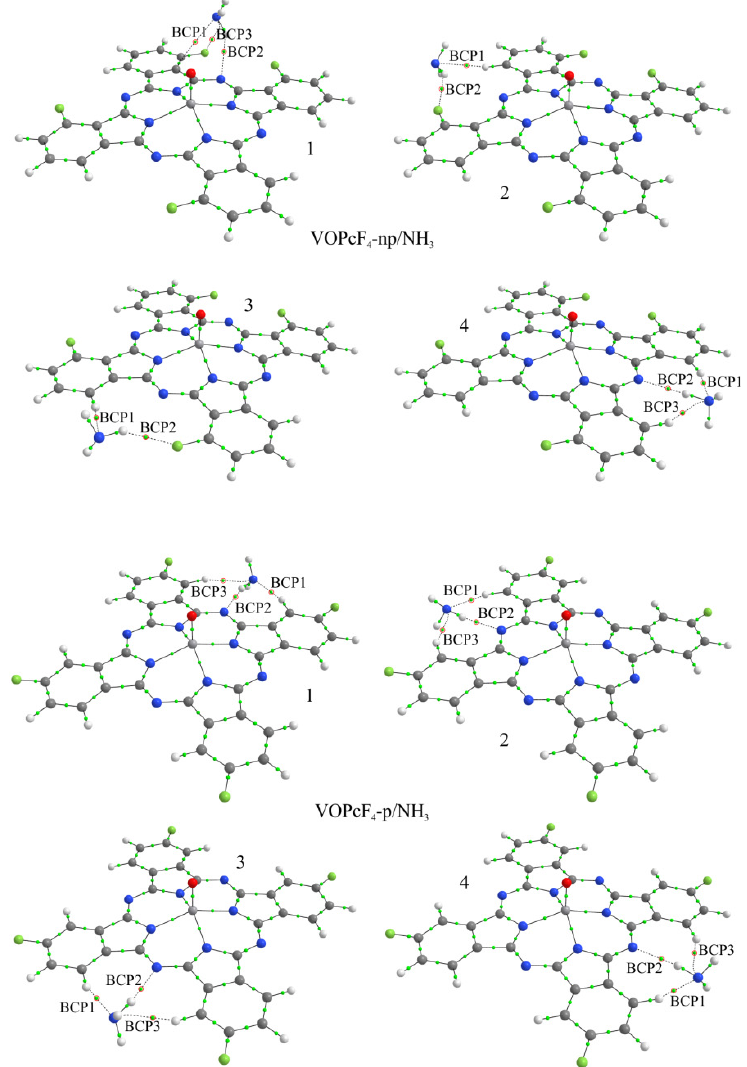
Figure 9. Structure of VOPcF 4 -np/NH 3 and VOPcF 4 -p/NH 3 aggregates and bond critical points in them. Red circles indicate BCPs characterizing the interaction of the ammonia molecule with phthalocyanine atoms. Table 2. The interaction parameters of the NH 3 molecule with cobalt